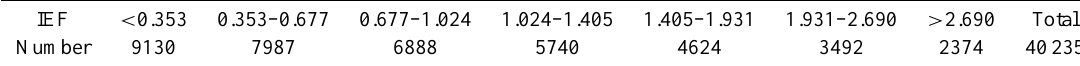
Table 1. Number of 5min data points for each subset.